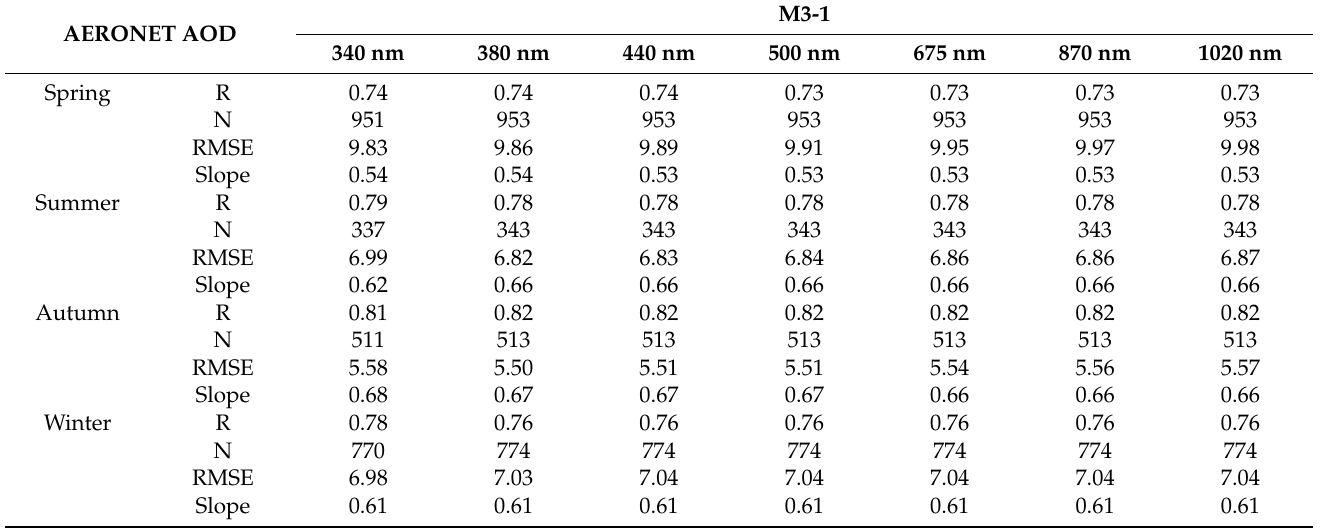
Table 5. Seasonal variation of R, RMSE, slope, and number of data used (N) in correlations between measured and estimated PM 2.5 (unit: µ g/m 3 ) values for various wavelengths. Estimated PM 2.5 values here are from the M3-1 model using AERONET AOD. The unit of RMSE is µ g/m 3